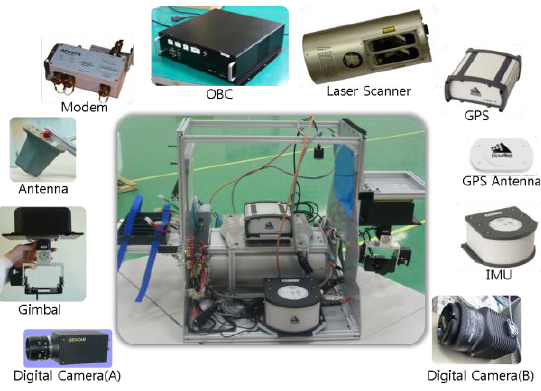
Figure 3. Integrated sensors and supporting modules in the aerial